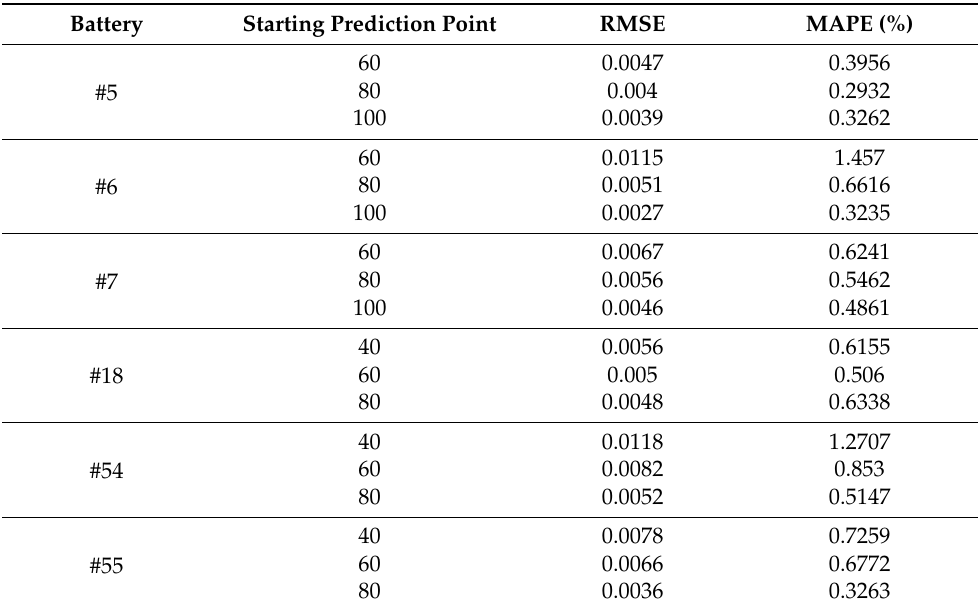
Table 3. Prediction RMSE and MAPE on comparisons for different starting points. Battery Starting Prediction Point RMSE MAPE